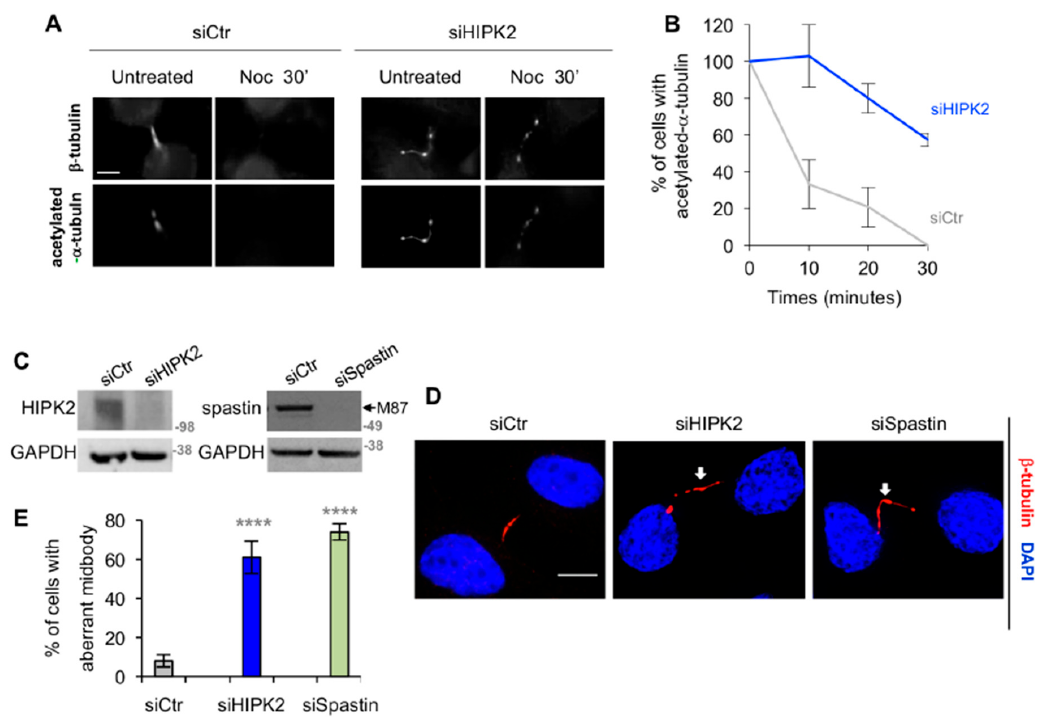
Figure 2. HIPK2-depleted cells show aberrant midbodies. ( A , B ) Indicated HeLa cells were analyzed by IF 96 h post transfection at the indicated time post nocodazole (Noc) treatment on ice. Telophase cells, showing acetylated tubulin at the midbody, were scored. In ( A ), representative immunostainings are shown. Bar, 5 µ M. In ( B ), the percentage of cells with acetylated tubulin at the midbody are reported as mean ± SEM from two independent experiments, each performed in duplicate, in which at least a total of 80 midbodies per condition were counted. ( C – E ) HeLa cells were transfected as in Figure 1A or with spastin-specific validated stealth siRNAs and analyzed 96 h post transfection by WB ( C ) and by IF ( D , E ). In ( C ), the arrow indicates the band corresponding to M87, the most abundant spastin form; M87 ∆ 4 was generally less abundant and barely detectable. In ( D ), representative immunostainings of siHIP2 and siSpastin telophase cells with aberrant midbody are shown. The arrows indicate tubulin-labeled puncta along the intercellular bridge. Bar, 5 µ M. In ( E ), the percentage of cells showing aberrant midbodies is reported as mean ± SEM from three independent experiments, in which at least total 150 midbodies per condition were analyzed. **** p < 0.0001, χ 2 test.